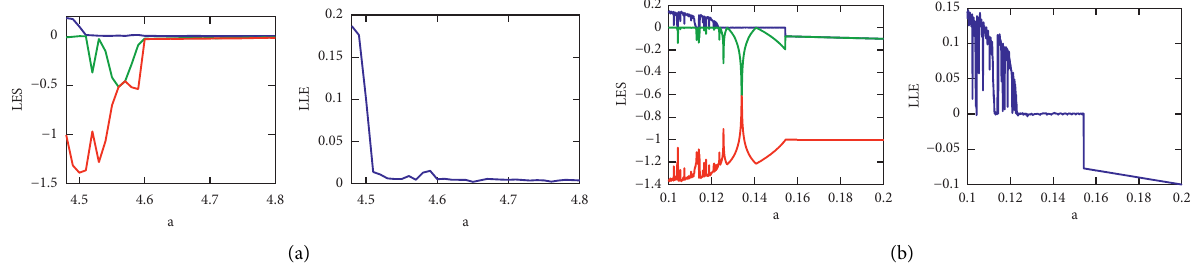
Figure 7: Lyapunov exponents spectrum (LES) and largest Lyapunov exponent (LLE) of system (1) versus a . (a) Lyapunov exponents spectrum (LES) and largest Lyapunov exponent (LLE) of system (1) versus a in b � 9.5, c � 1, and e � 1. (b) Lyapunov exponents spectrum (LES) and largest Lyapunov exponent (LLE) of system (1) versus a in b � 0.7, c � 1, and e � 1.